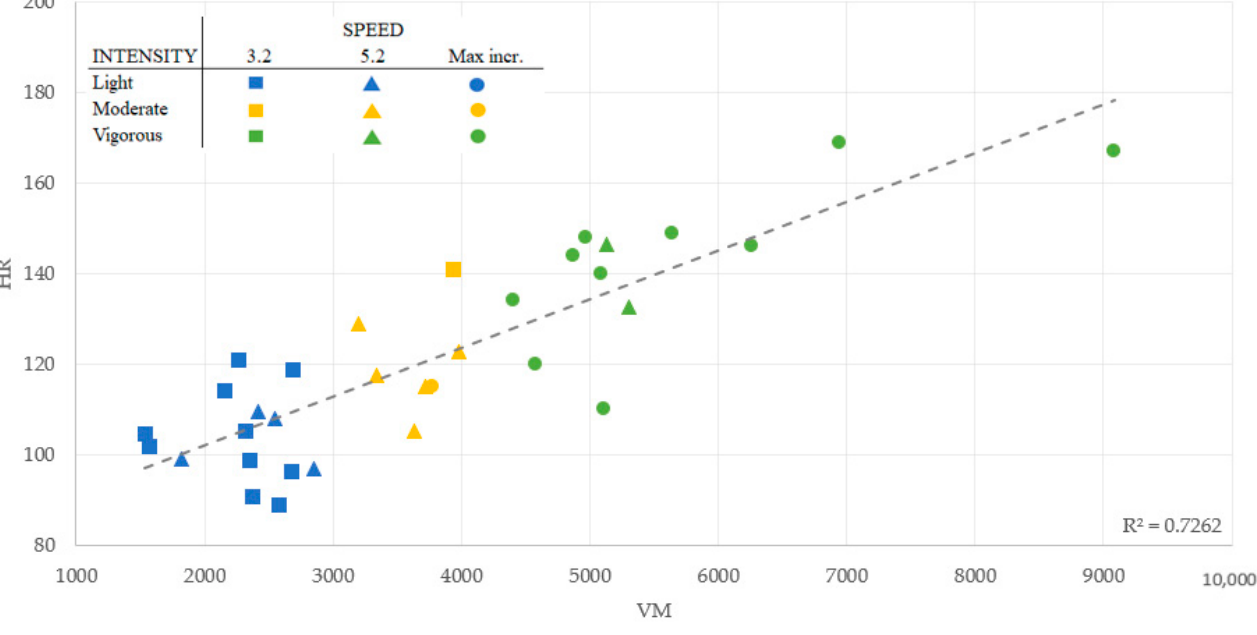
Figure 3. Lineal Regression Model: Vector Magnitude association with the Heart Rate.